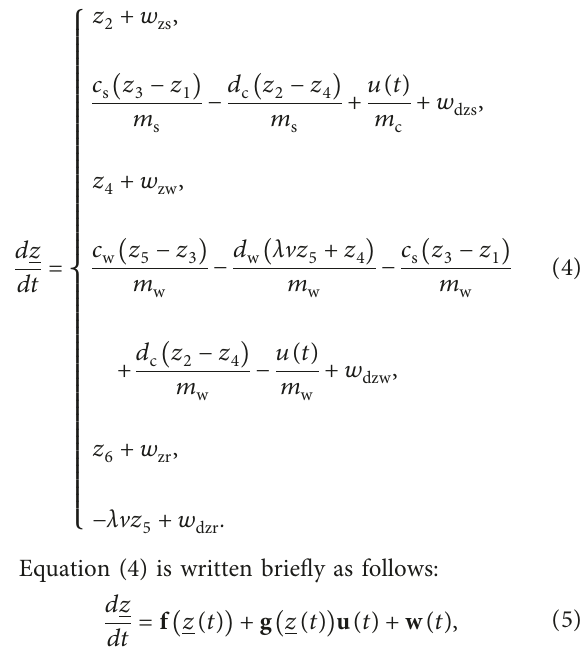
as the function of the road profile and velocity of the car. r